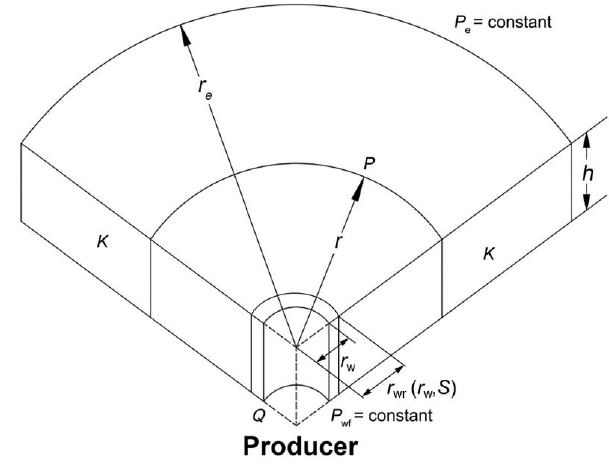
Figure 2. Schematic diagram of the gas reservoir model.